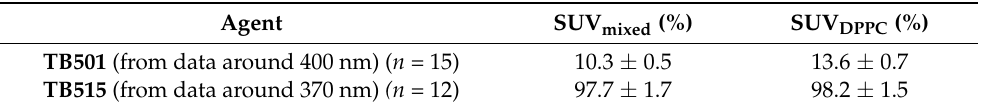
Table 1 . The calculated EE of the two kinds of SUVs (SUV mixed and SUV DPPC ) for the two antitubercular agent candidates (TB501 and TB515) determined from Figure 3, (mean ± 3SE%).